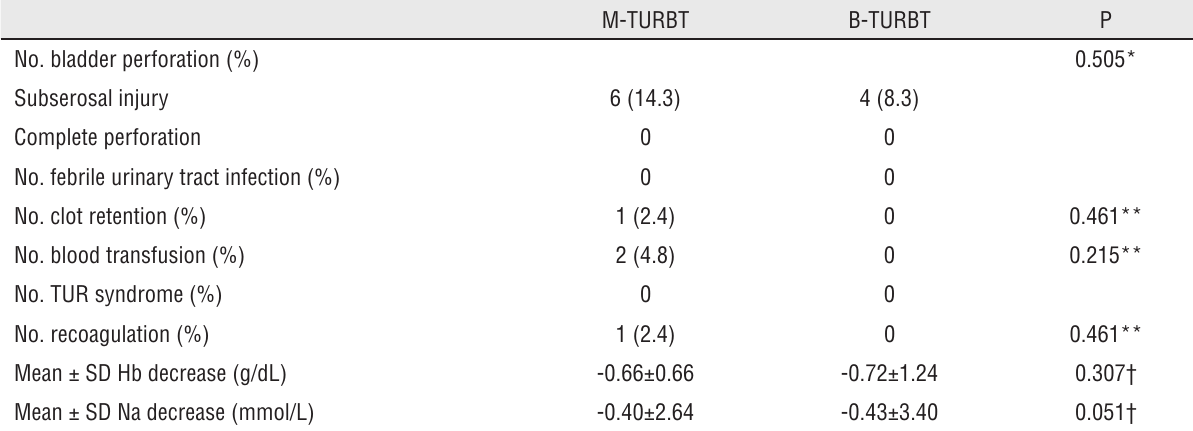
Table 3 - postoperative complications and adverse